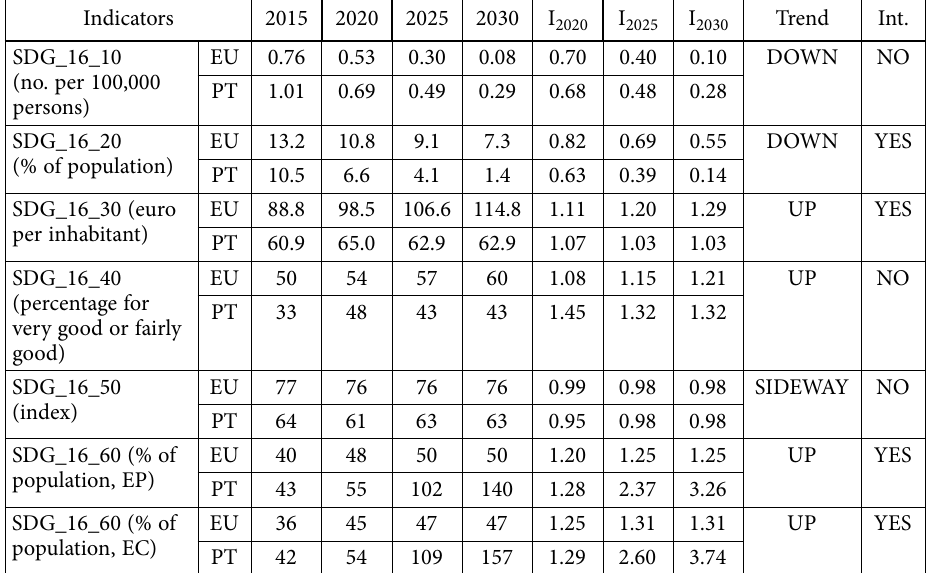
Table 17. SDG 16 – Peace, justice and strong institutions